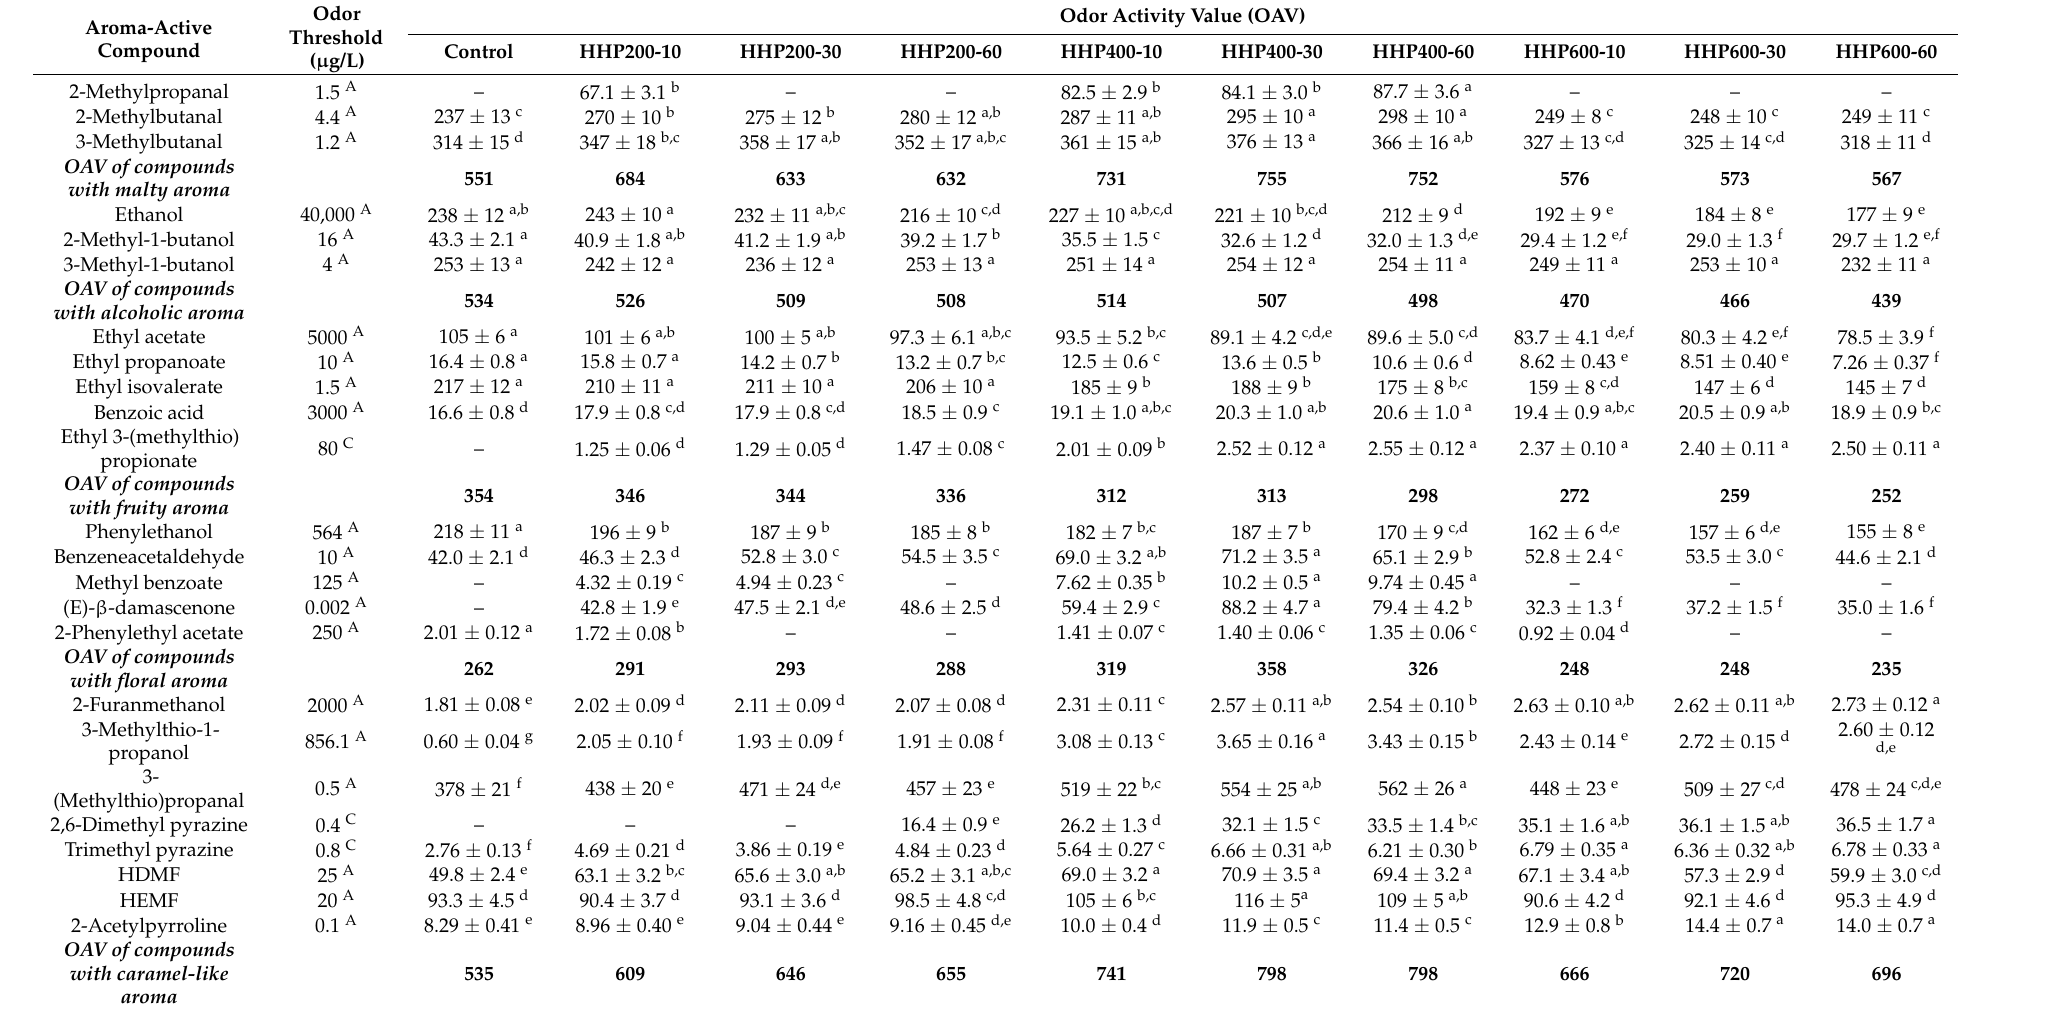
Table 2. OAVs of aroma-active compounds detected in the control and